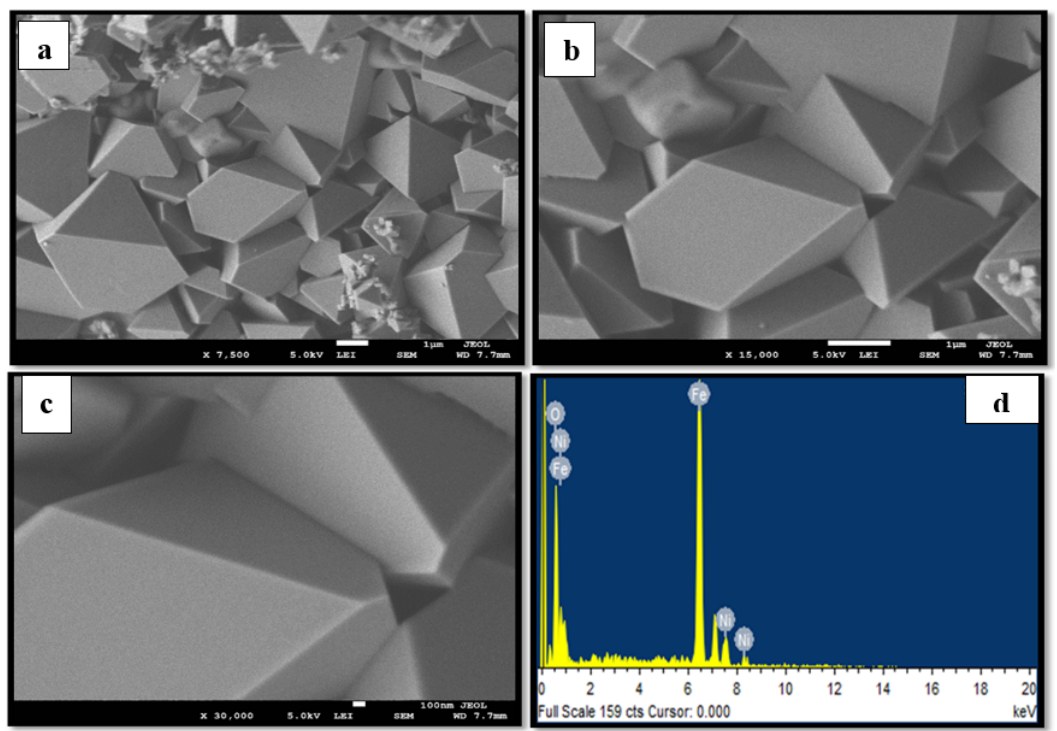
Figure 2. Representative ( a – c ) FESEM images at different magnifications and ( d ) EDS spectrum of the synthesized spinel (2:1) NiFe 2 O 4 MNPs.